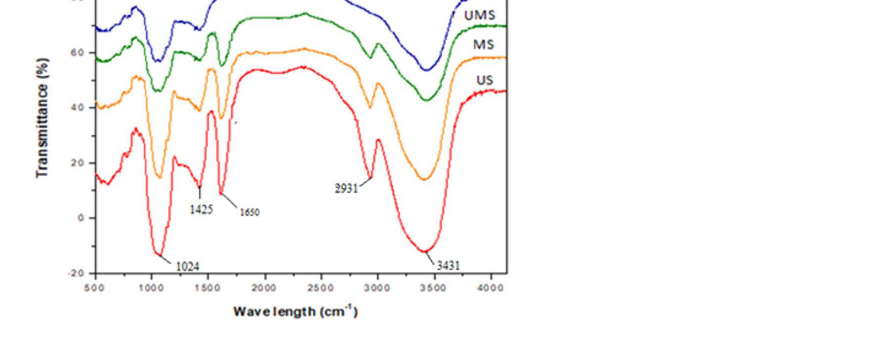
Figure 3. FT-IR spectra of alginate and IEs in Ca-alginate beads generated with UMS treatment.